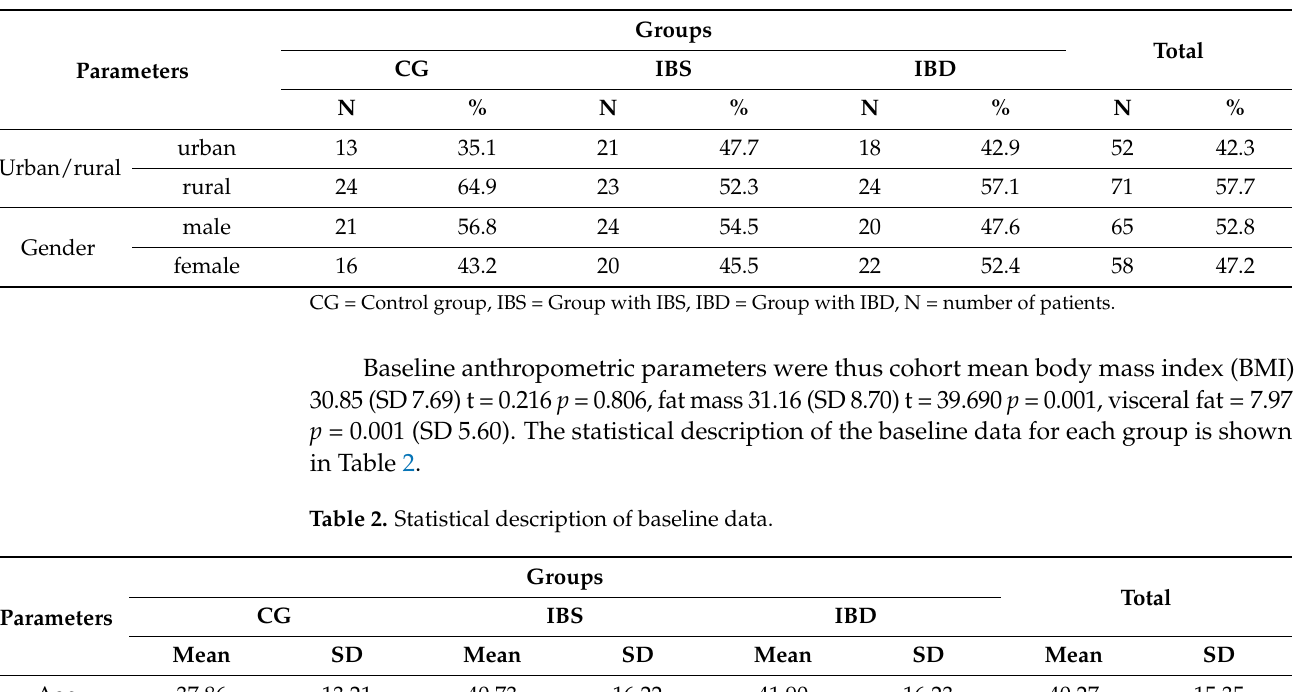
Table 1. Demographic description of patients.